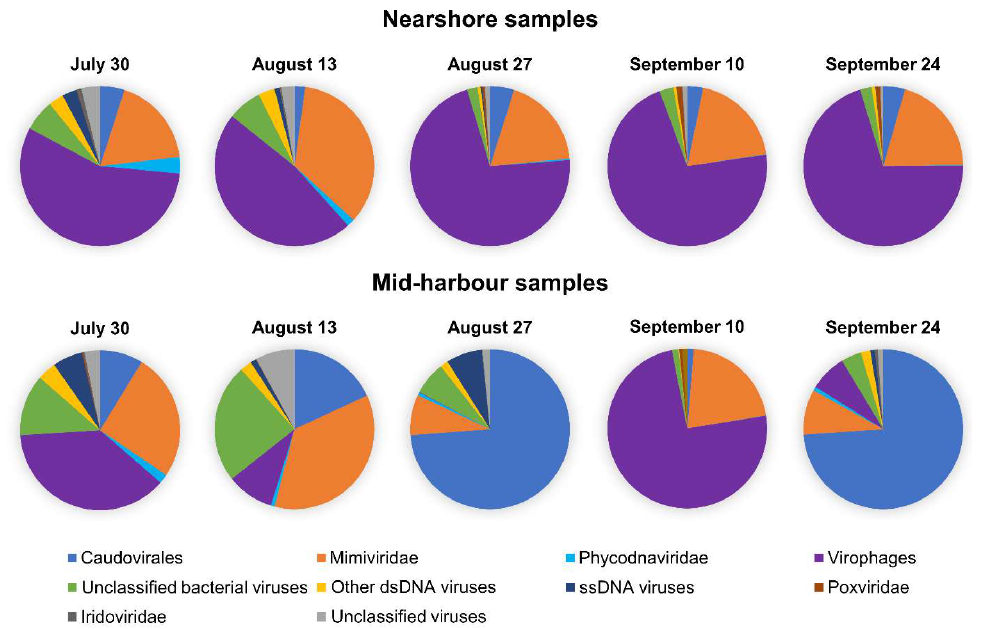
Figure 2. Individual virus communities for each of the 10 metagenomes.